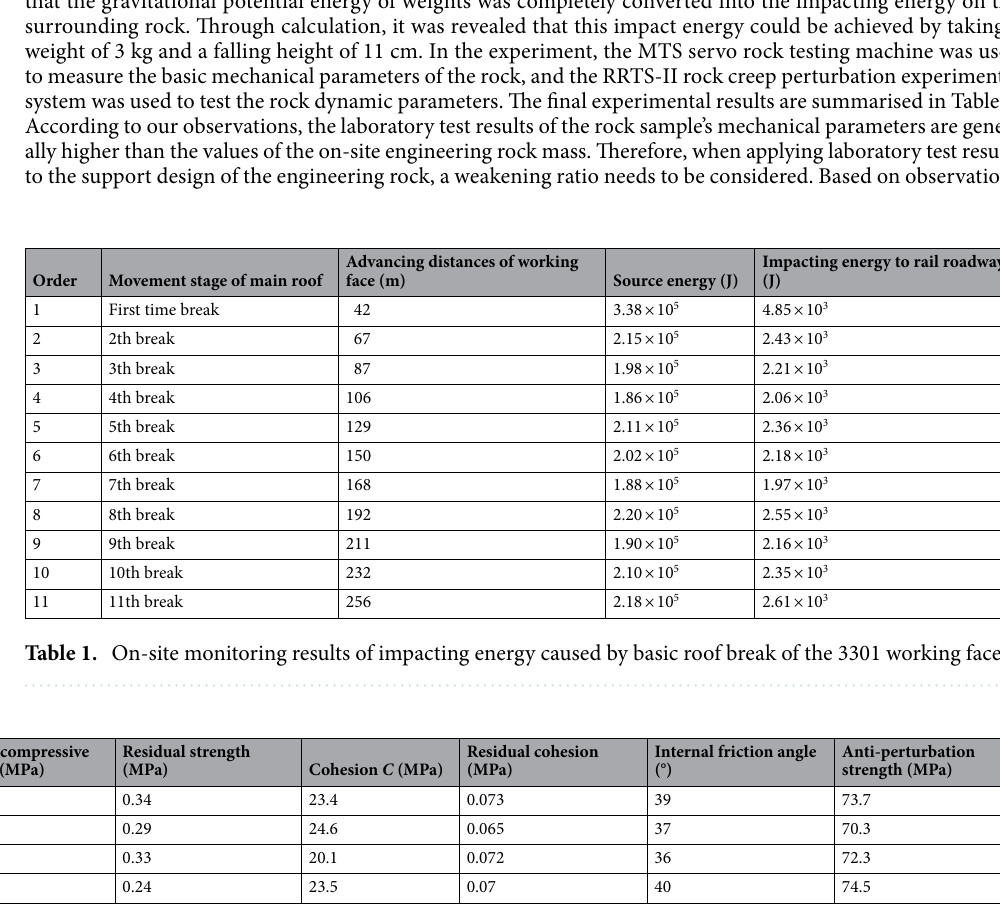
Table 2. Test results of the surrounding rock’s mechanical